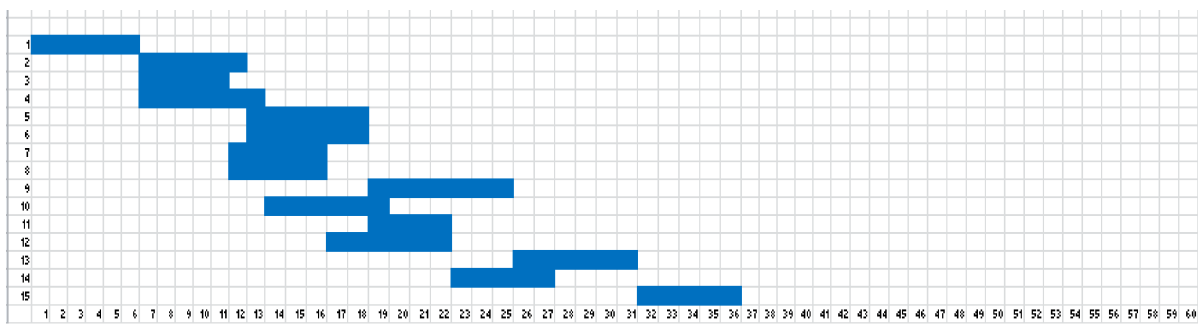
Figure 8. Gantt chart of the 4th experiment relaxed resource